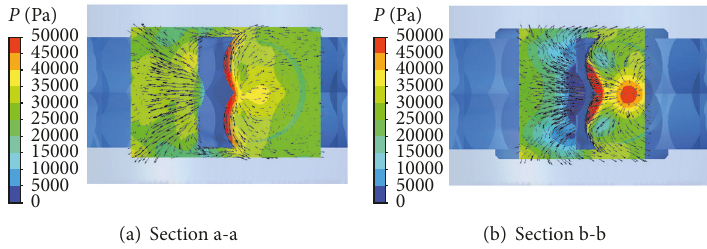
Figure 19: Static pressure distributions and absolute velocity vectors of Blade A ( 𝜃 ∗ = 48 ∘ , 𝑛 = 250 ,000 min −1